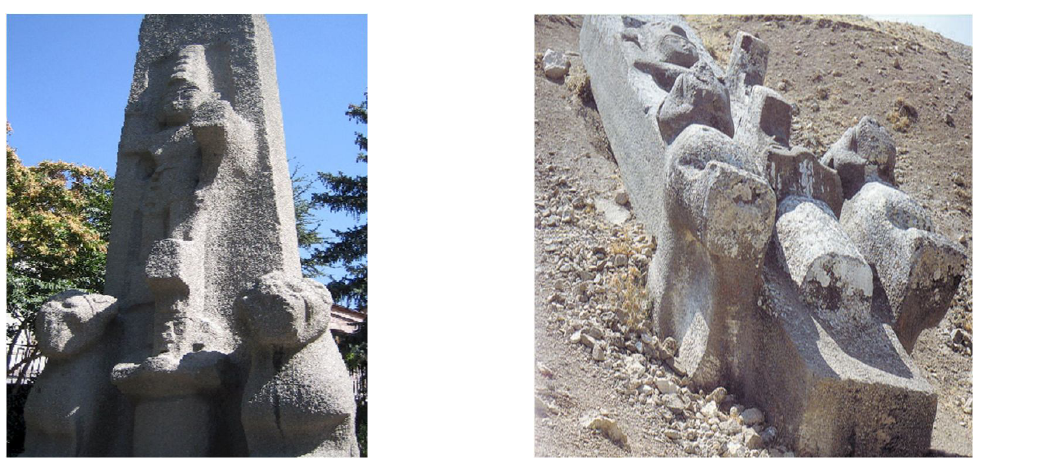
Picture 7: Fasıllar Monument (Imitation) Picture 8: Fasıllar Monument